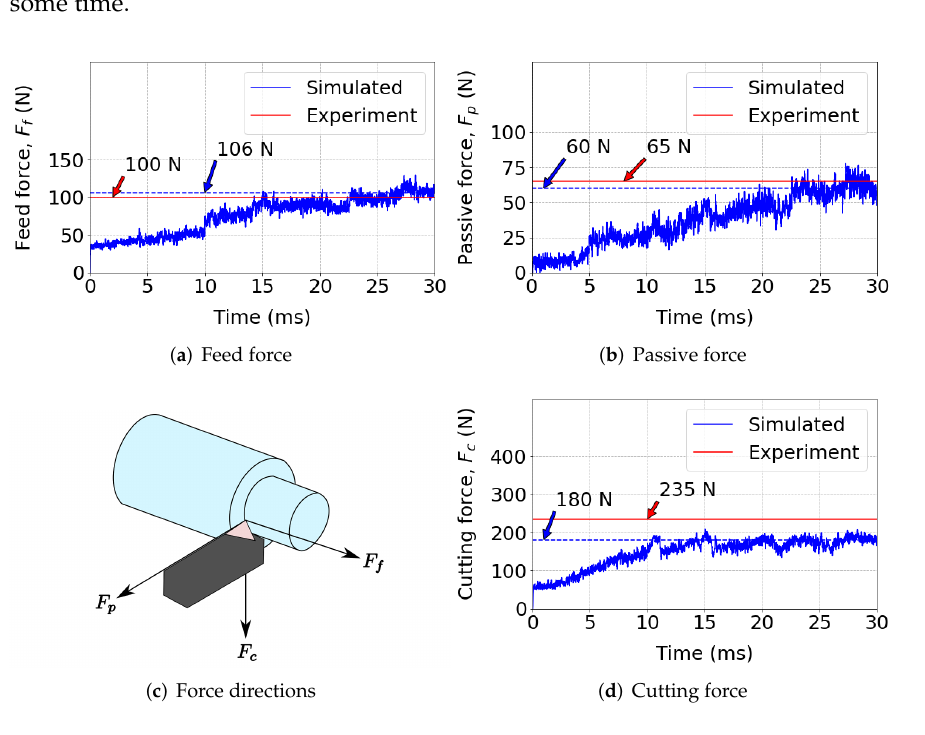
Figure 11. A comparison of Cutting forces predicted by 3D machining model with experimental ob-